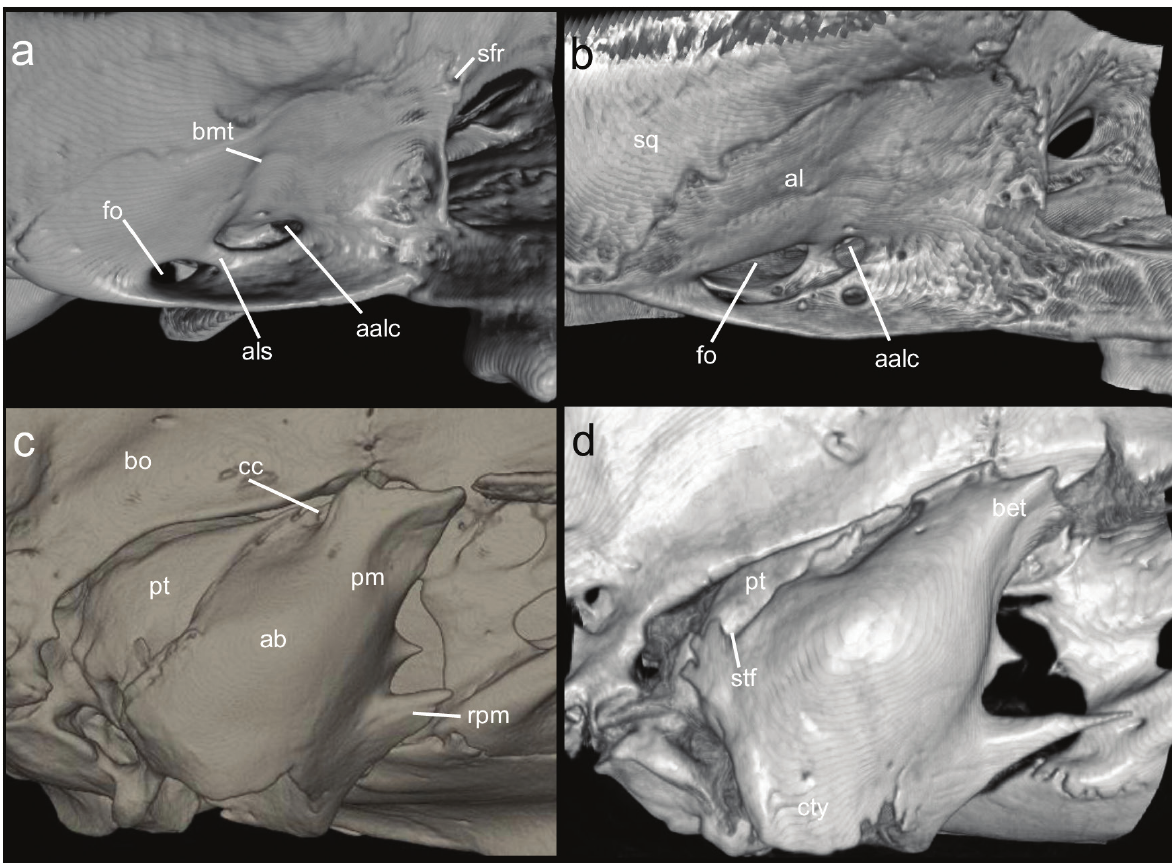
Figure 12. Three-dimensional reconstructions of details of the alisphenoid region ( a, b ) and the auditory bulla ( c, d ) based on mi- cro-CT data of the holotypes of Mindomys kutuku sp. nov. ( a, c MECN 5809; Cordillera de Kutukú, Ecuador) and Mindomys ham- mondi ( b, d NHMUK 13.10.24.58; Mindo, Ecuador). Acronyms: aalc, anterior opening of alisphenoid canal; ab, auditory bulla; al, alisphenoid; als, alisphenoid strut; bet, bony Eustachian tube; bo, basioccipital; cc, carotid canal, cty, crista tympanica; fo, foramen ovale; bmt, buccinators-masticatory trough; pt, petrosal; sfr, sphenofrontal foramen; sq, squamosal; stf, stapedial foramen; rpm, rostral process of malleus. Figures are not to scale to facilitate